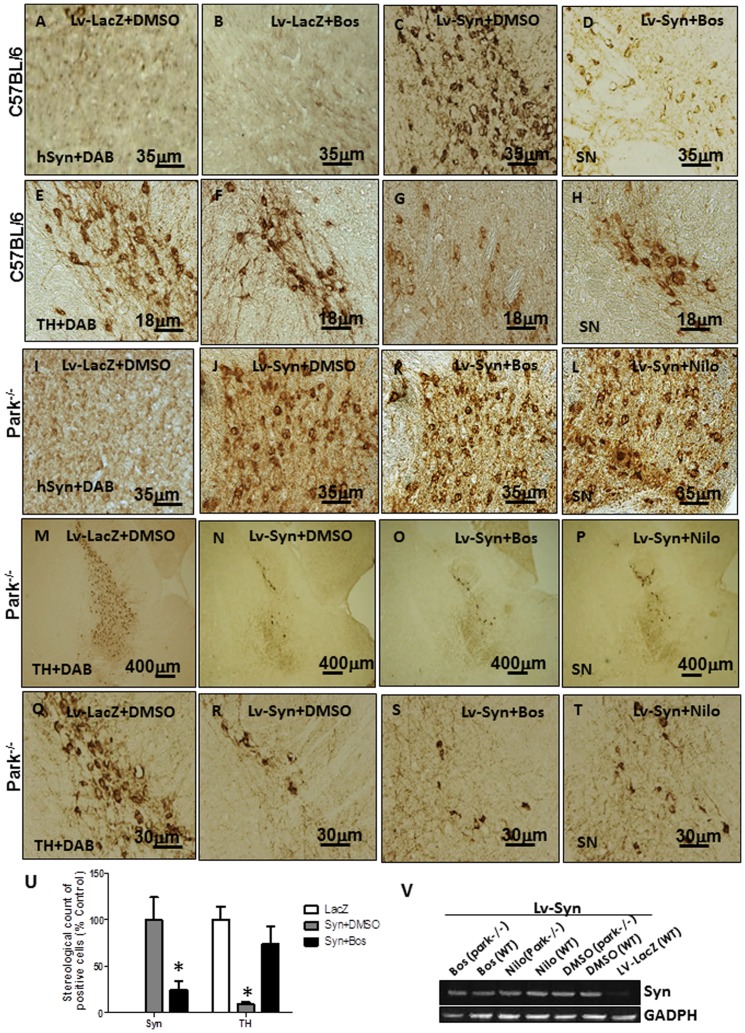
TKI clears α-Synuclein and protects TH+ neurons in a parkin-dependent manner.Immunostaining of 20 µm thick mouse brain sections showing human α-Synuclein counterstained with DAB in the SN of lentiviral injected A) LacZ WT mice treated with DMSO for 3 weeks, B) LacZ WT treated with 5 mg/kg bosutinib, C) human WT α-Synuclein in WT mice treated with DMSO, and D) human WT α-Synuclein in WT mice treated with 5 mg/kg bosutinib (n = 10). TH+ labeling counterstained with DAB in the SN of lentiviral injected E) LacZ WT mice treated with DMSO for 3 weeks, F) LacZ WT treated with 5 mg/kg bosutinib, G) human WT α-Synuclein in WT mice treated with DMSO, and H) human WT α-Synuclein in WT mice treated with 5 mg/kg bosutinib (n = 10). Human α-Synuclein in the SN of parkin−/− mice counterstained with DAB injected with I) LacZ treated with DMSO, or human α-Synuclein treated with J) DMSO, K) 5 mg/kg bosutinib and L) 10 mg/kg nilotinib for 3 weeks (n = 10). Staining of TH+ neurons in the SN of parkin−/− mice counterstained with DAB injected with M) LacZ treated with DMSO O) is higher magnification, or lentiviral α-Synuclein treated with N) DMSO, R) is a higher magnification O) 5 mg/kg bosutinib, S) is a higher magnification and P) 10 mg/kg nilotinib, T) is a higher magnification (n = 10). U) graph represents stereological counting and V) RT-PCR showing equal amount of α-Synuclein mRNA relative to GADPH in both parkin−/− and WT mice with and without TKIs (n = 10). Asterisk indicates significantly different, means±SEM, ANOVA, Newman Keuls.